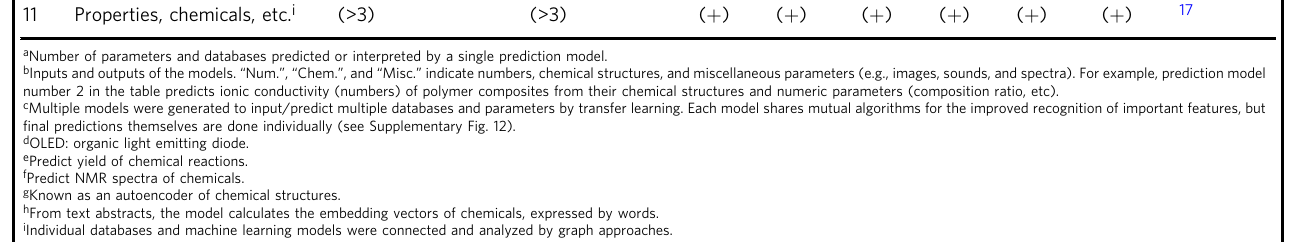
Table 1 Comparison of the present work with previous prediction models.